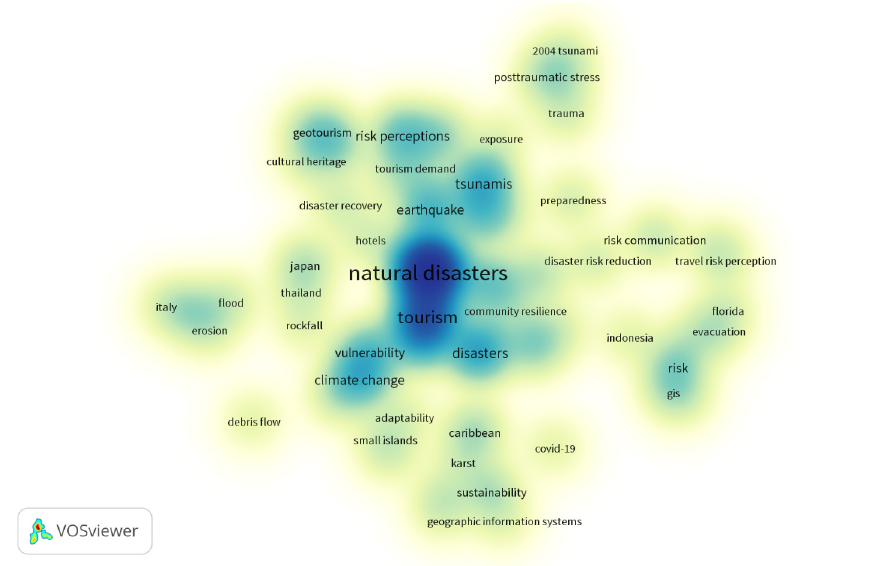
Figure 7. The main co-occurrence of keywords of all